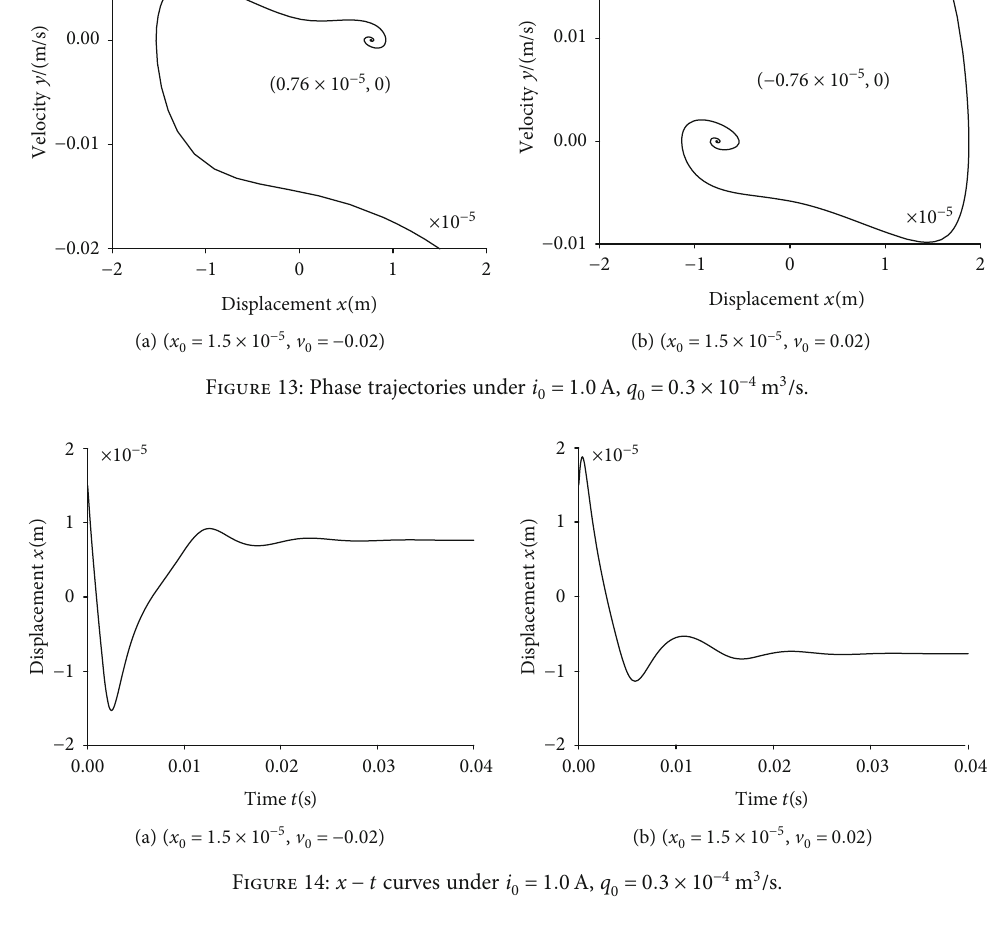
Figure 14: x − t curves under i